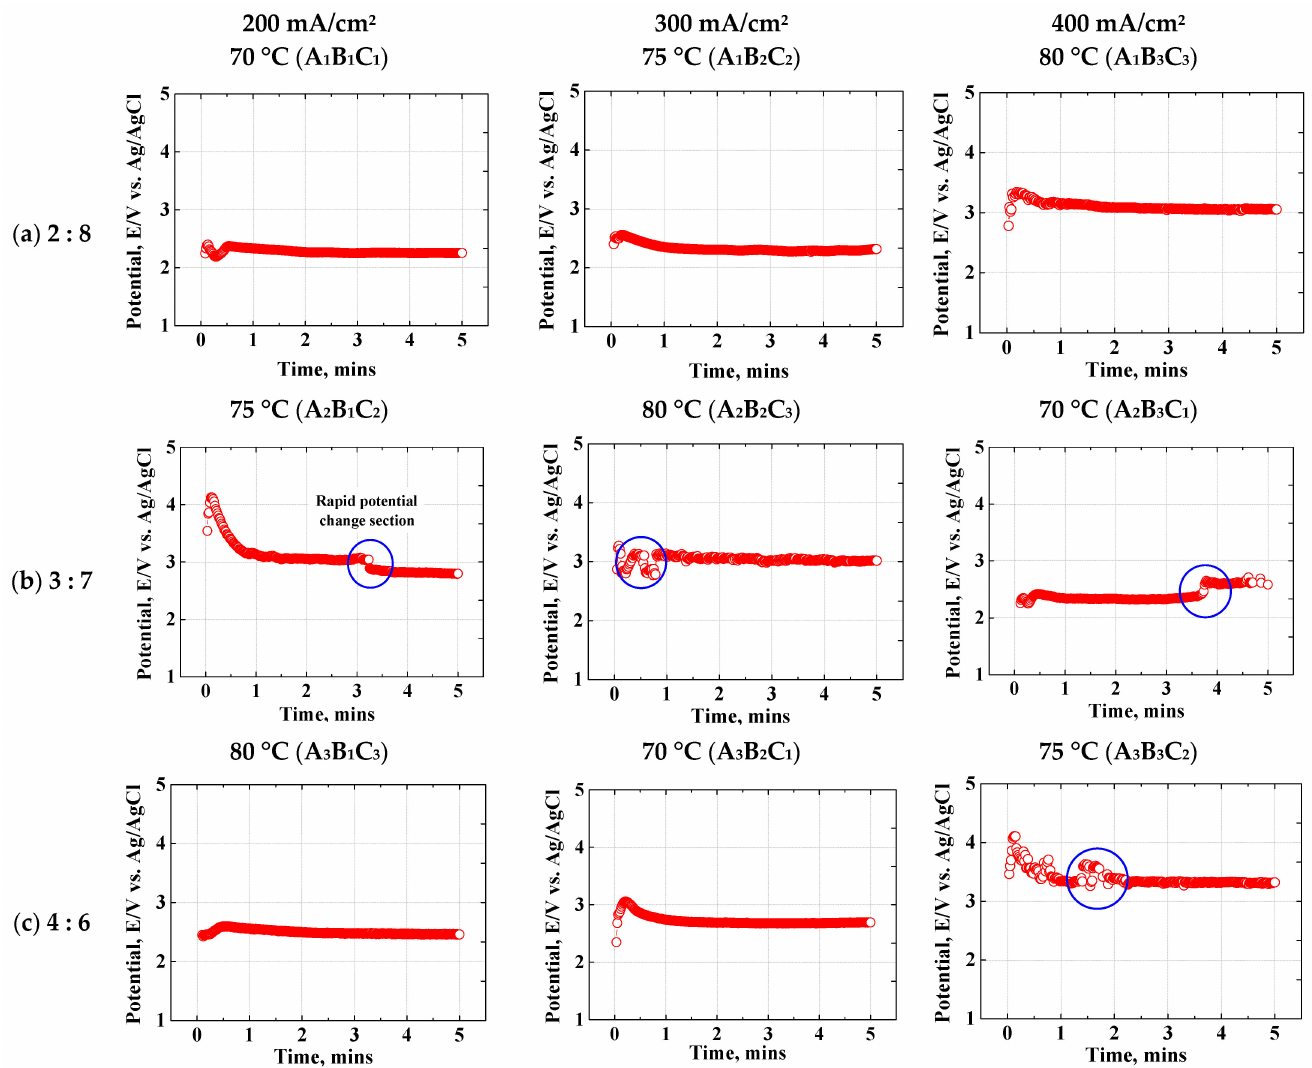
Figure 3. Galvanostatic electropolishing experiment using an electrolyte containing sulfuric acid (95 wt%) and phosphoric acid (85 wt%) in ratios of ( a ) 2:8, ( b ) 3:7, and ( c )